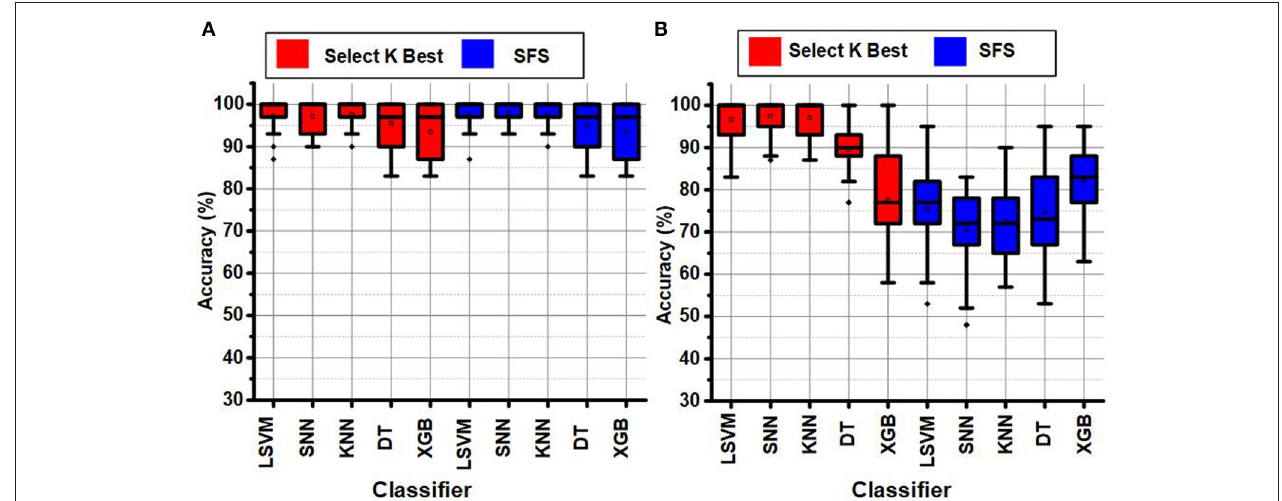
FIGURE 7 | Classification results after feature selection for (A) SEED, and (B) DREAMER data set.